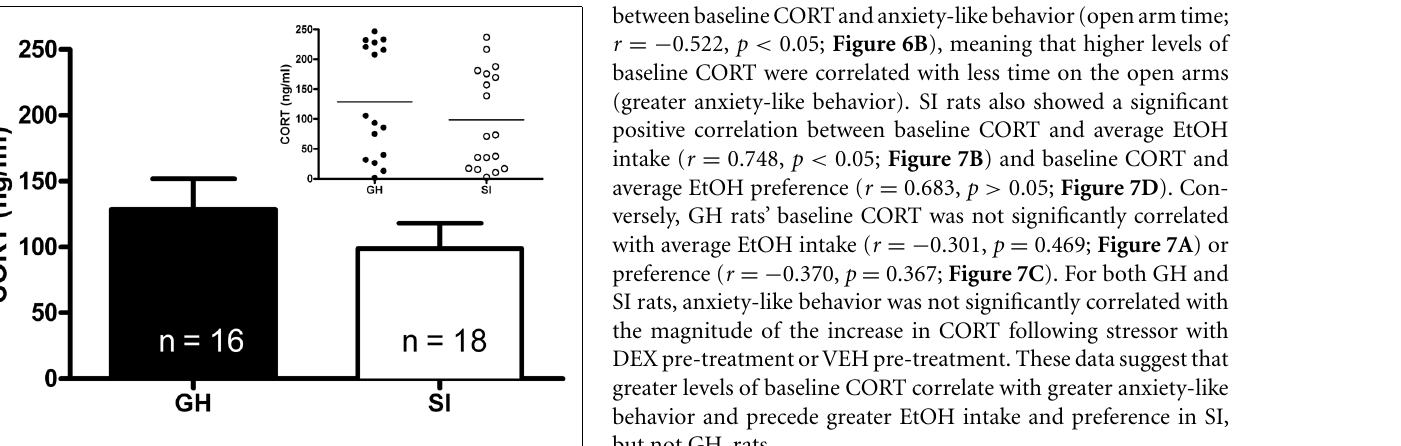
FIGURE 3 | Baseline plasma corticosterone (CORT). At PND 85–95 (after 6 weeks of GH/SI), baseline CORT levels did not differ between group housed (GH) and socially isolated (SI) rats ( t = 0.09867, p = 0.1656).The inset shows the individual differences in CORT levels within groups.